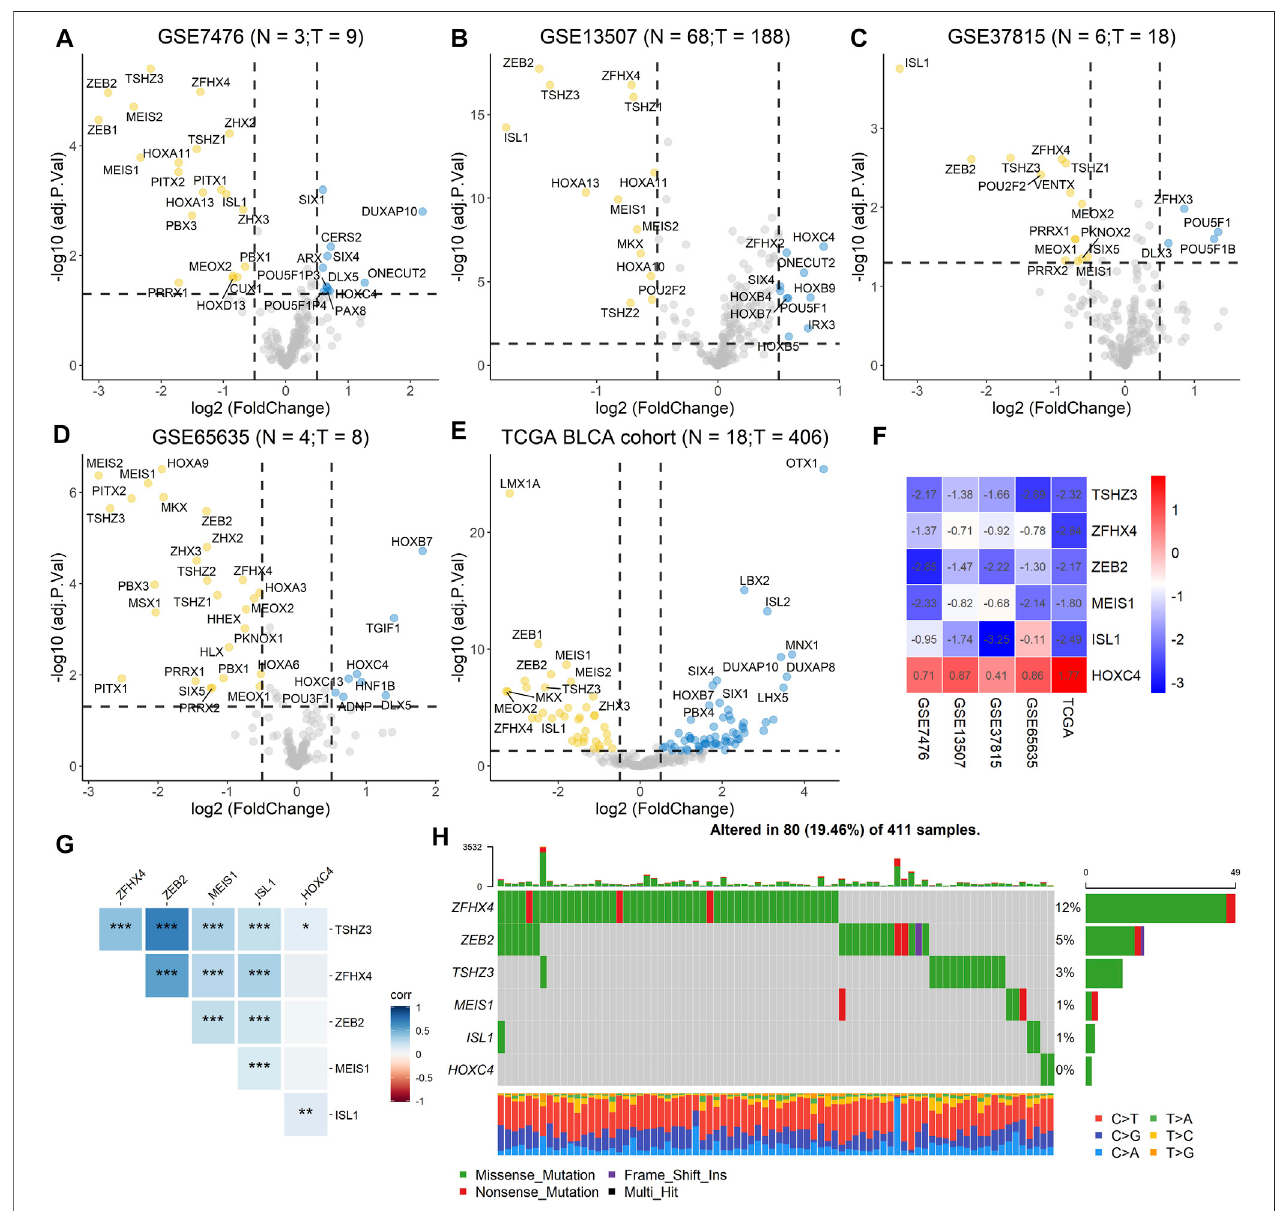
FIGURE2| Identi fi cation ofDEHGsfor BLCA, analysisofthe mutation landscape, and correlationanalysisofthesixDEHGs. (A) DEHGsforBLCA in theGSE7476 dataset. (B) DEHGsfor BLCA in the GSE13507 dataset. (C) DEHGsfor BLCA inthe GSE37815 dataset. (D) DEHGs for BLCAin the GSE65635 dataset. (E) DEHGs for BLCA in the TCGA dataset. (F) LogFC values of each gene in different datasets (GSE7476, GSE13507, GSE37815, GSE65635, and TCGA). (G) Analysis of the correlations among the six DEHGs. (H) Mutation landscape of the six DEHGs in TCGA BLCA patients.